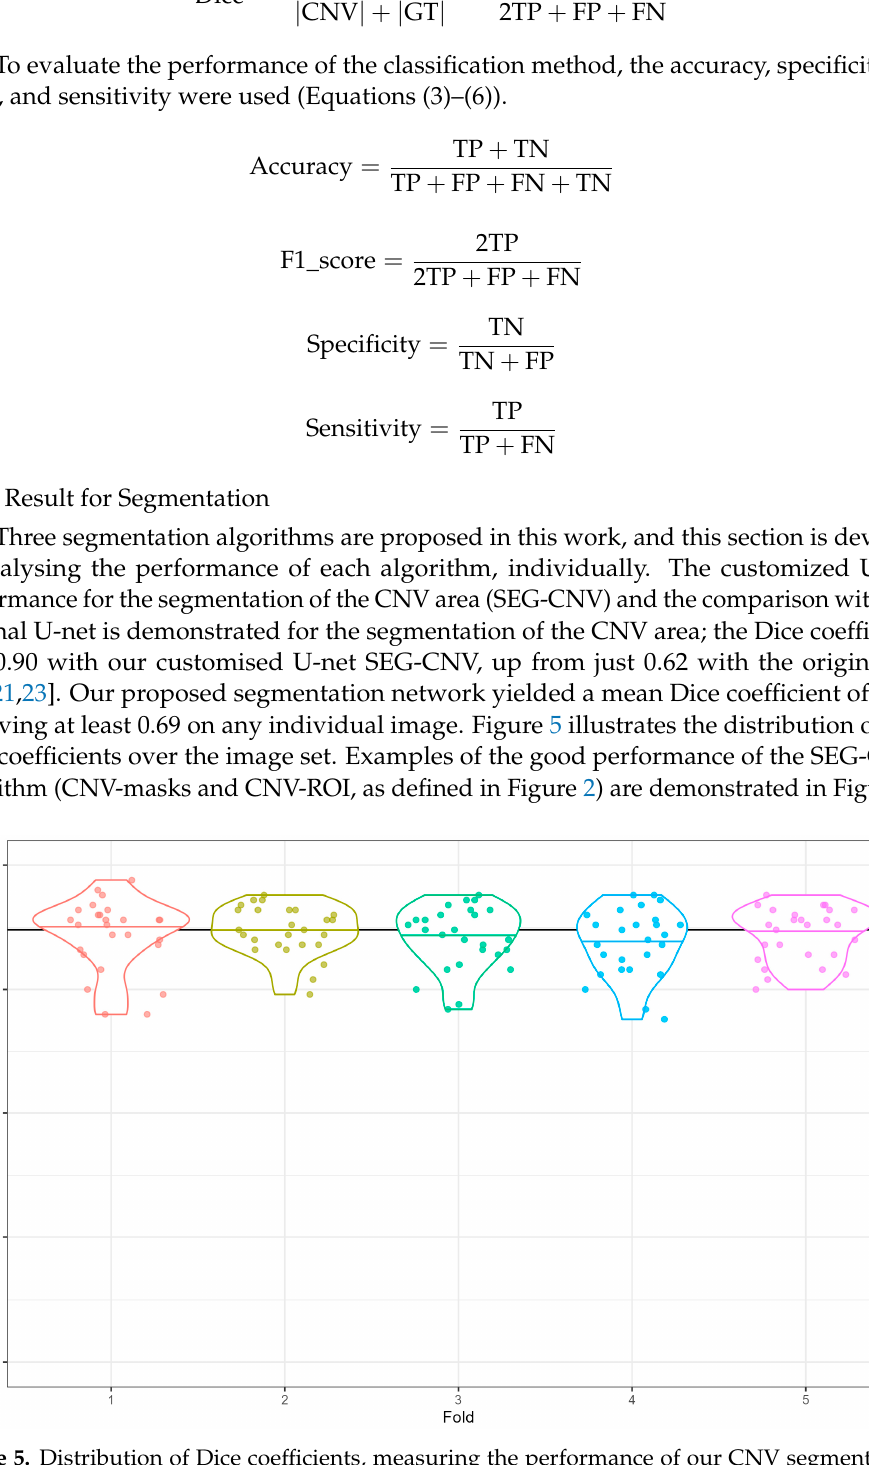
Figure 6. Examples of performance of SEG-CNV ( A , E ) in outer retinal en-face images. ( B , F ) Ground Truth, ( C , G ) Predicted CNV mask by SEG-CNV represented by the white pixel on black back- ground, ( D , H ) CNV ROI by SEG-CNV as fi nal output of this segmentation. SEG-PA is designed to localise the peripheral arcade, as depicted in Figure 7. Figure 7B,F shows an area to check for the presence or absence of the peripheral arcade features in the CNV lesion. To show the performance of the SEG-DH algorithms, Figure 8 shows the original choroidal enface image and the area predicted by SEG-DH.